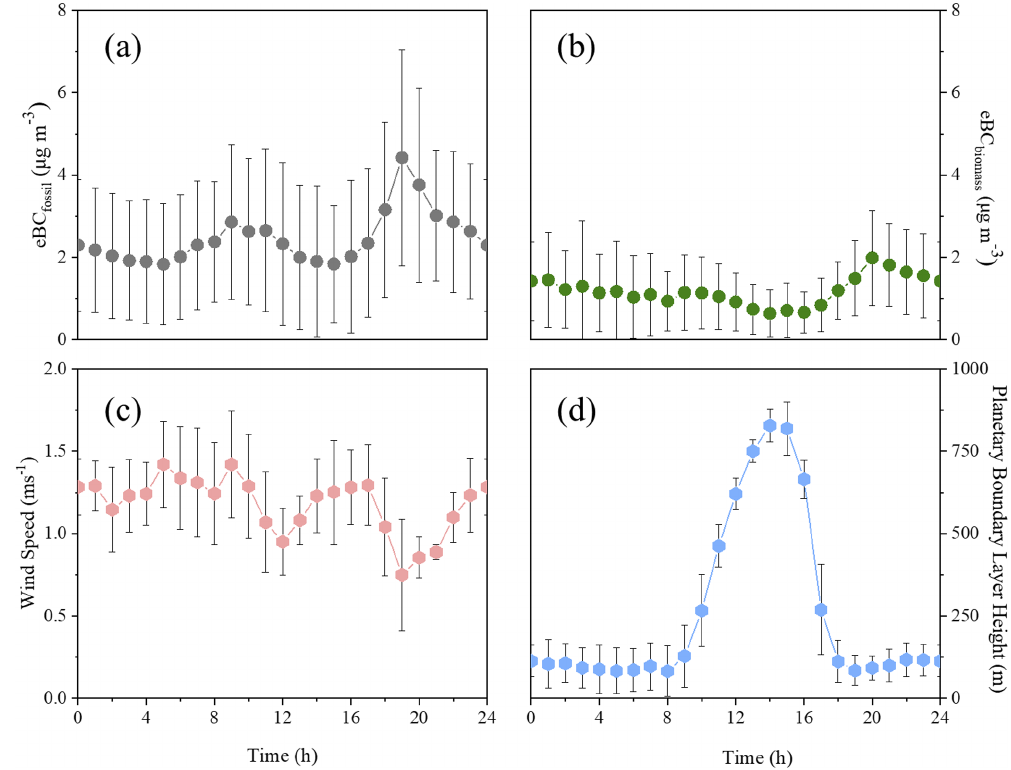
Figure 2. (a) Diel variations of the e BC from fossil fuel combustion ( e BC fossil ) and (b) the e BC from biomass burning ( e BC biomass ), (c) wind speed (ms − 1 ), and (d) planetary boundary layer height (m). The black bars of each hourly-averaged point show the standard deviation.